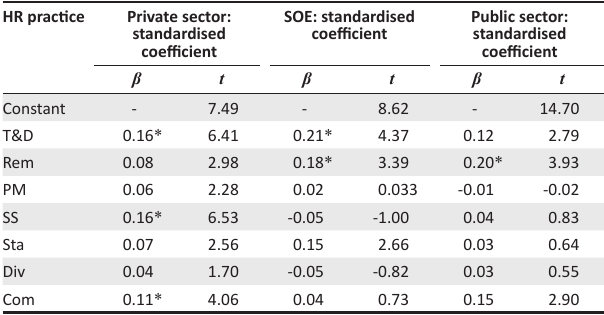
TABLE 6: Unique contributions of predictors to variance in organisational commitment (only standardised coefficients are presented). HR